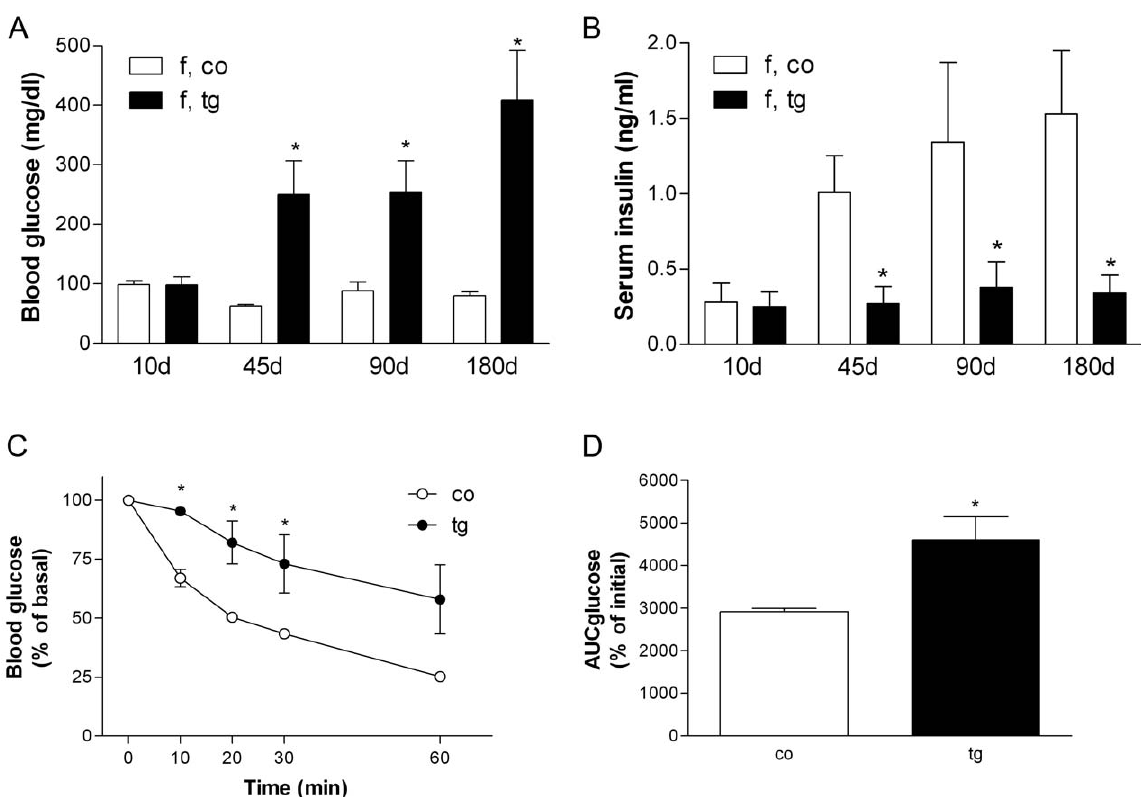
Figure 4. In vivo investigations. (A) Randomly fed (10 days) and fasting blood glucose (45-180 days), and (B) randomly fed (10 days) and postprandial serum insulin levels (45–90 days), (C) insulin tolerance test, (D), and area under glucose curve (AUC) during insulin tolerance test shown in C; co, control; tg, GIPR dn transgenic; Data represent means and SEM, * p , 0.05 vs. age-matched control.